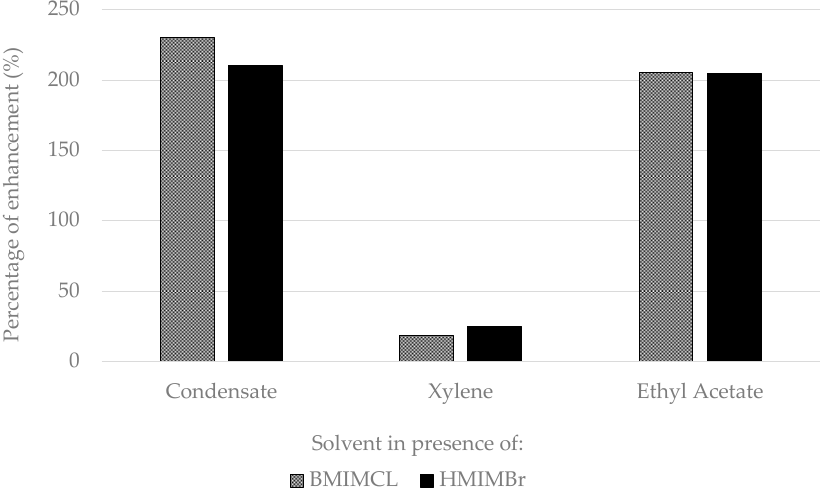
Figure 8. Percentage of enhancement of extracted solvent UV-VIS absorbance in the presence of ionic liquid.